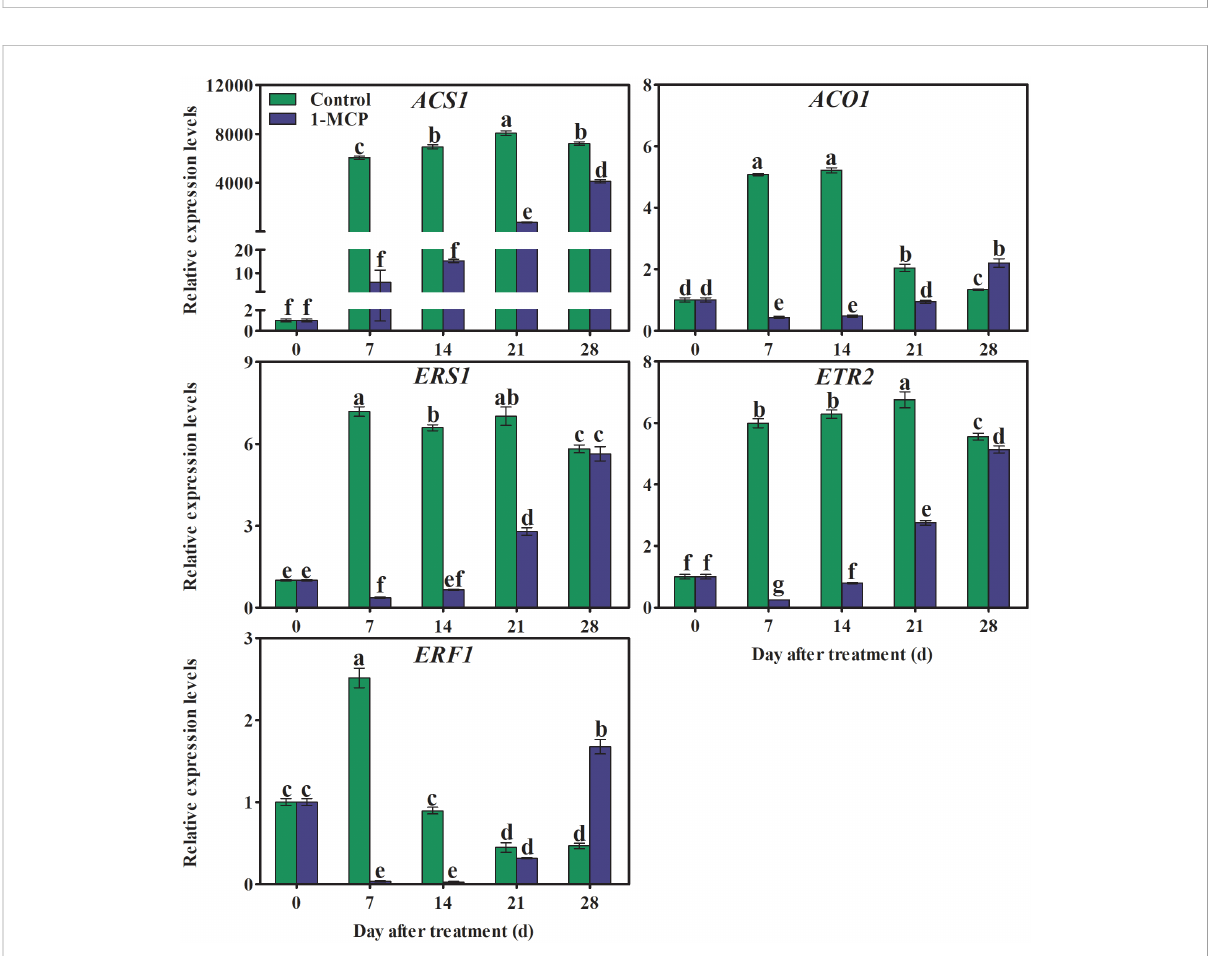
FIGURE 6 Effects of 1-MCP treatment on the expression levels of genes associated with ethylene biosynthesis ( ACS1 and ACO1 ), receptors ( ERS1 and ETR2 ), and signaling ( ERF1 ) in the peel of ‘ Yuluxiang ’ pear during storage. Data are mean ± SE ( n = 3); values labeled with different letters represent a signi fi cant difference at p